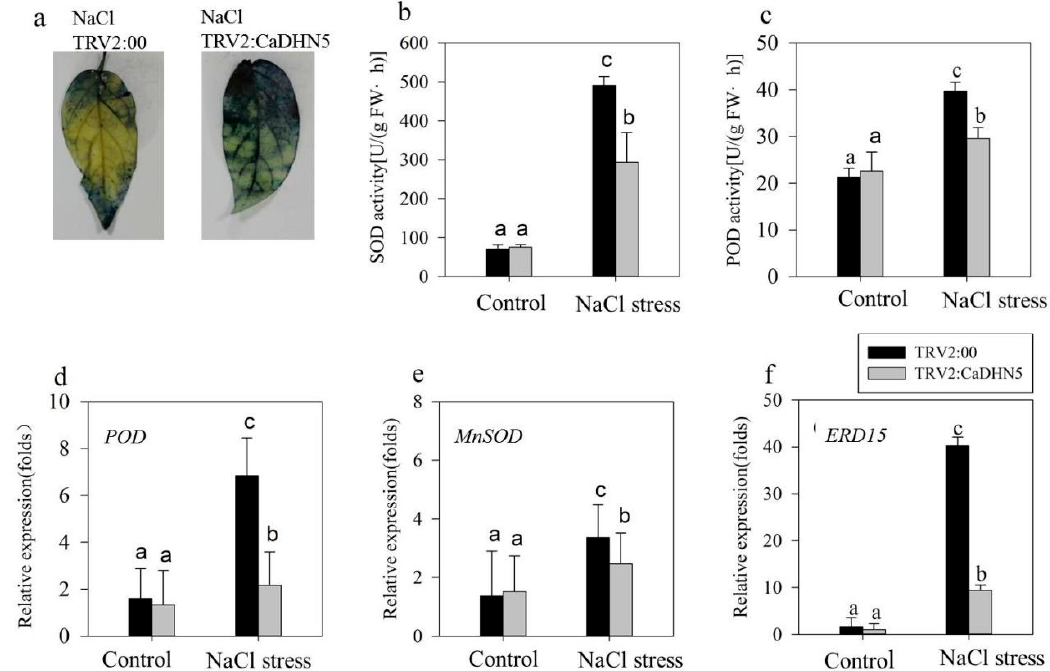
Figure 5. Determination of oxidative stress resistance and stress-related gene expression in NaCl treatment. ( a ) Results of NBT-stained pepper plants under NaCl treatment; ( b ) SOD activity under NaCl stress; ( c ) POD activity under NaCl treatment; ( d ) POD relative expression under NaCl treatment; € MnSOD relative expression under NaCl treatment; ( f ) ERD15 relative expression under NaCl treatment. Data significantly di ff erent are indicated with letters above the error bars ( ± S.D.). The di ff erent letters with the bars indicate significant di ff erences as determined using Tukey HSD’s multiple range tests ( p < 0.05).